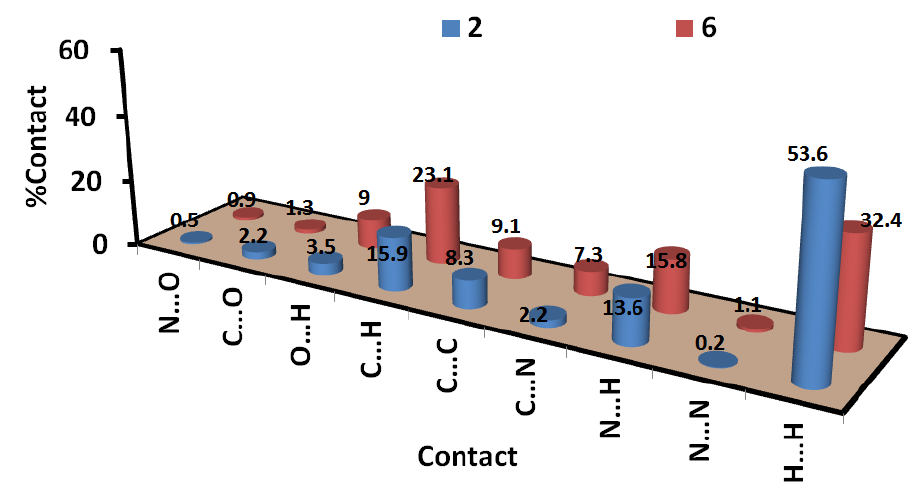
Figure 7. All intermolecular interactions in compounds 2 and 6 .